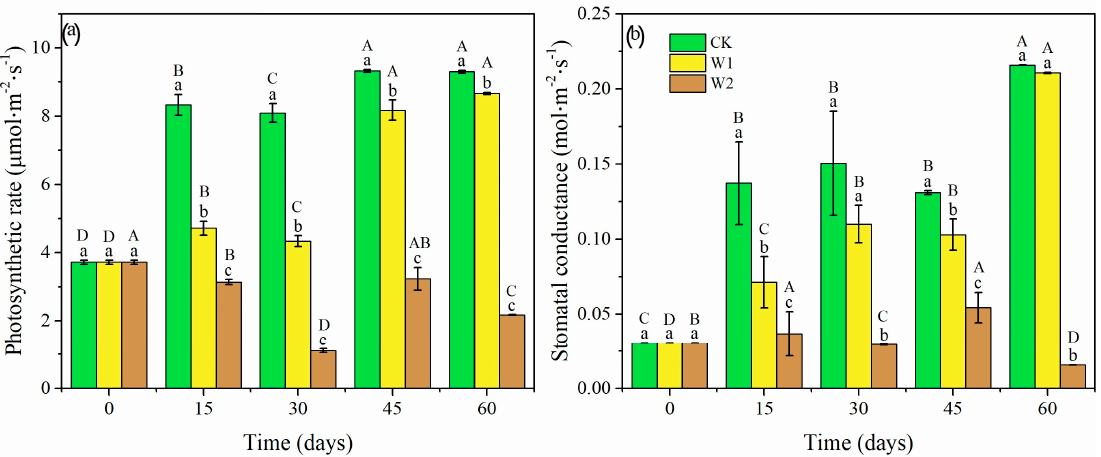
Figure 3. Photosynthetic rate ( a ) and stomatal conductance ( b ) in Mongolian oak seedlings under different drought intensities and durations. Uppercase letters represent the significant differences in the same treatment at different times ( p < 0.05), and lowercase letters represent the significant differences between different treatments at the same time ( p <